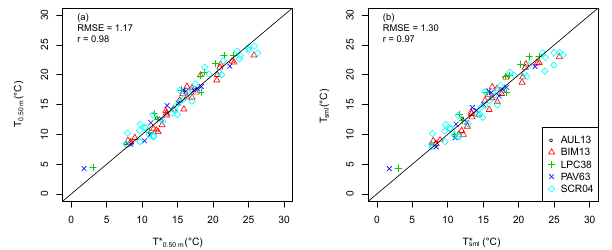
Figure 12. Bias for the temperature at 0.50m as a function of the month of the year. Asterisks indicate statistically significant differ- ences from zero at the 0.05